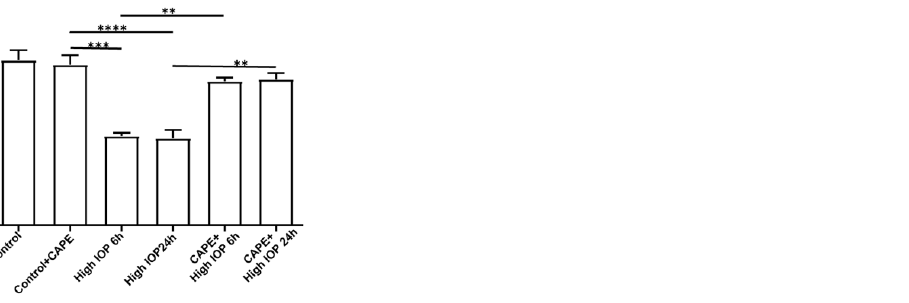
Figure 7. CAPE enhances retinal ganglion cell survival in the retina 6 h or 24 h after transient ischemia/reperfusion. The number of RBPMS-positive cells were counted from flat mounts of retina. The histogram shows the mean ± SD, n = 4; ** p < 0.01 *** p < 0.001, **** p < 0.0001. Adapted from Reference [60].